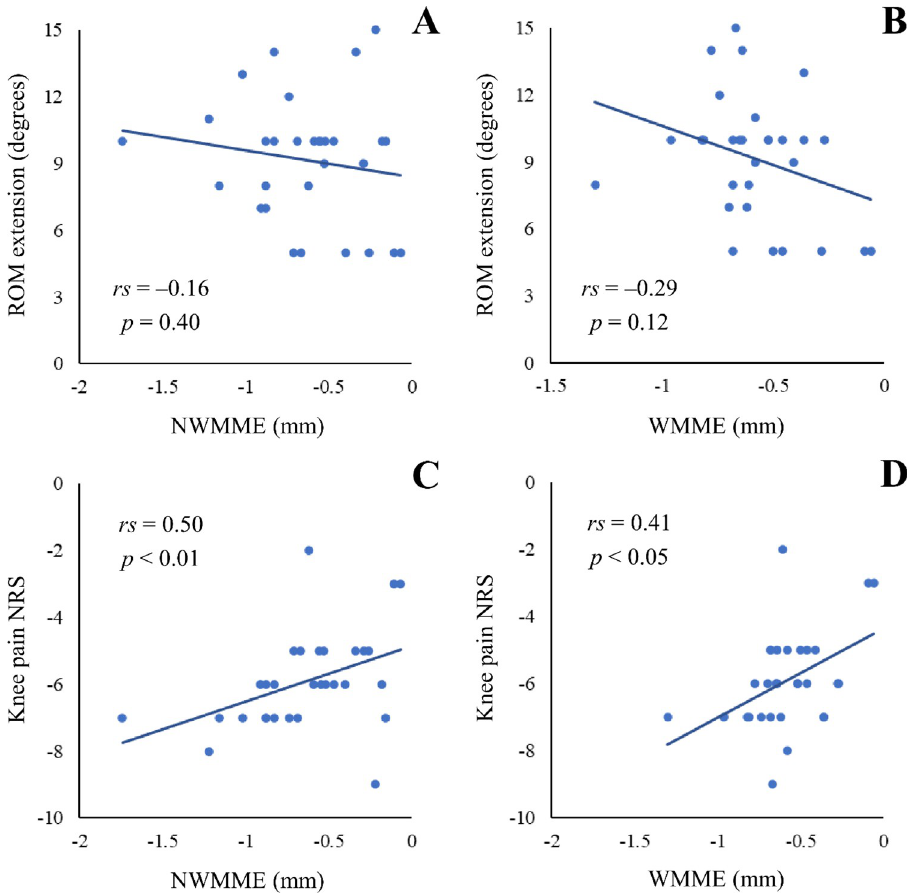
Fig 5. Scatter plot of changes in the parameters from baseline to 8 weeks. Between NWMME and ROM (A), WMME and ROM (B), NWMME and pain score (C), and WMME and pain score (D). All approximately straight lines are shown as the eye guide. Abbreviations: ROM, range of motion; NWMME, non-weight-bearing medial meniscal extrusion; WMME, weight-bearing medial meniscal extrusion; NRS, numerical rating scale; rs , Spearman’s rank correlation coefficient; p , p